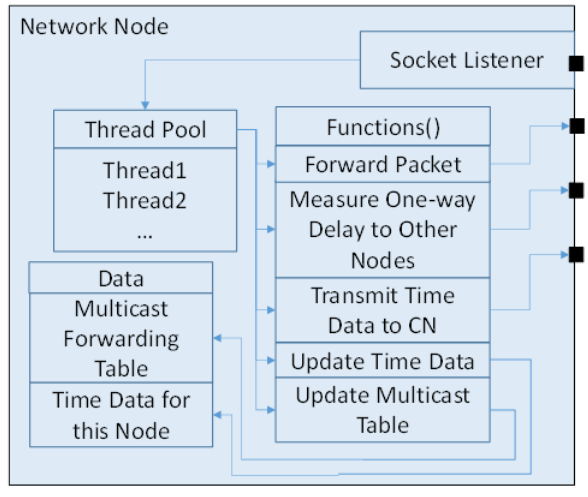
Fig. 7. Architecture of Network Node